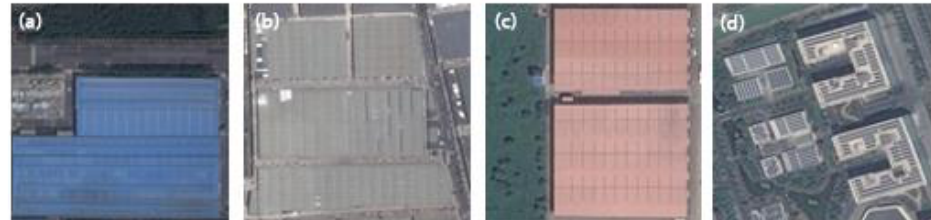
Figure 4. Examples of different types of industrial parks: ( a ) metal rooftops, mainly in blue; ( b ) con- crete rooftops, mainly in grey; ( c ) clay rooftops, mainly in dark or red color; ( d ) concrete rooftops, which have a smaller occupied area compared with the former three types.